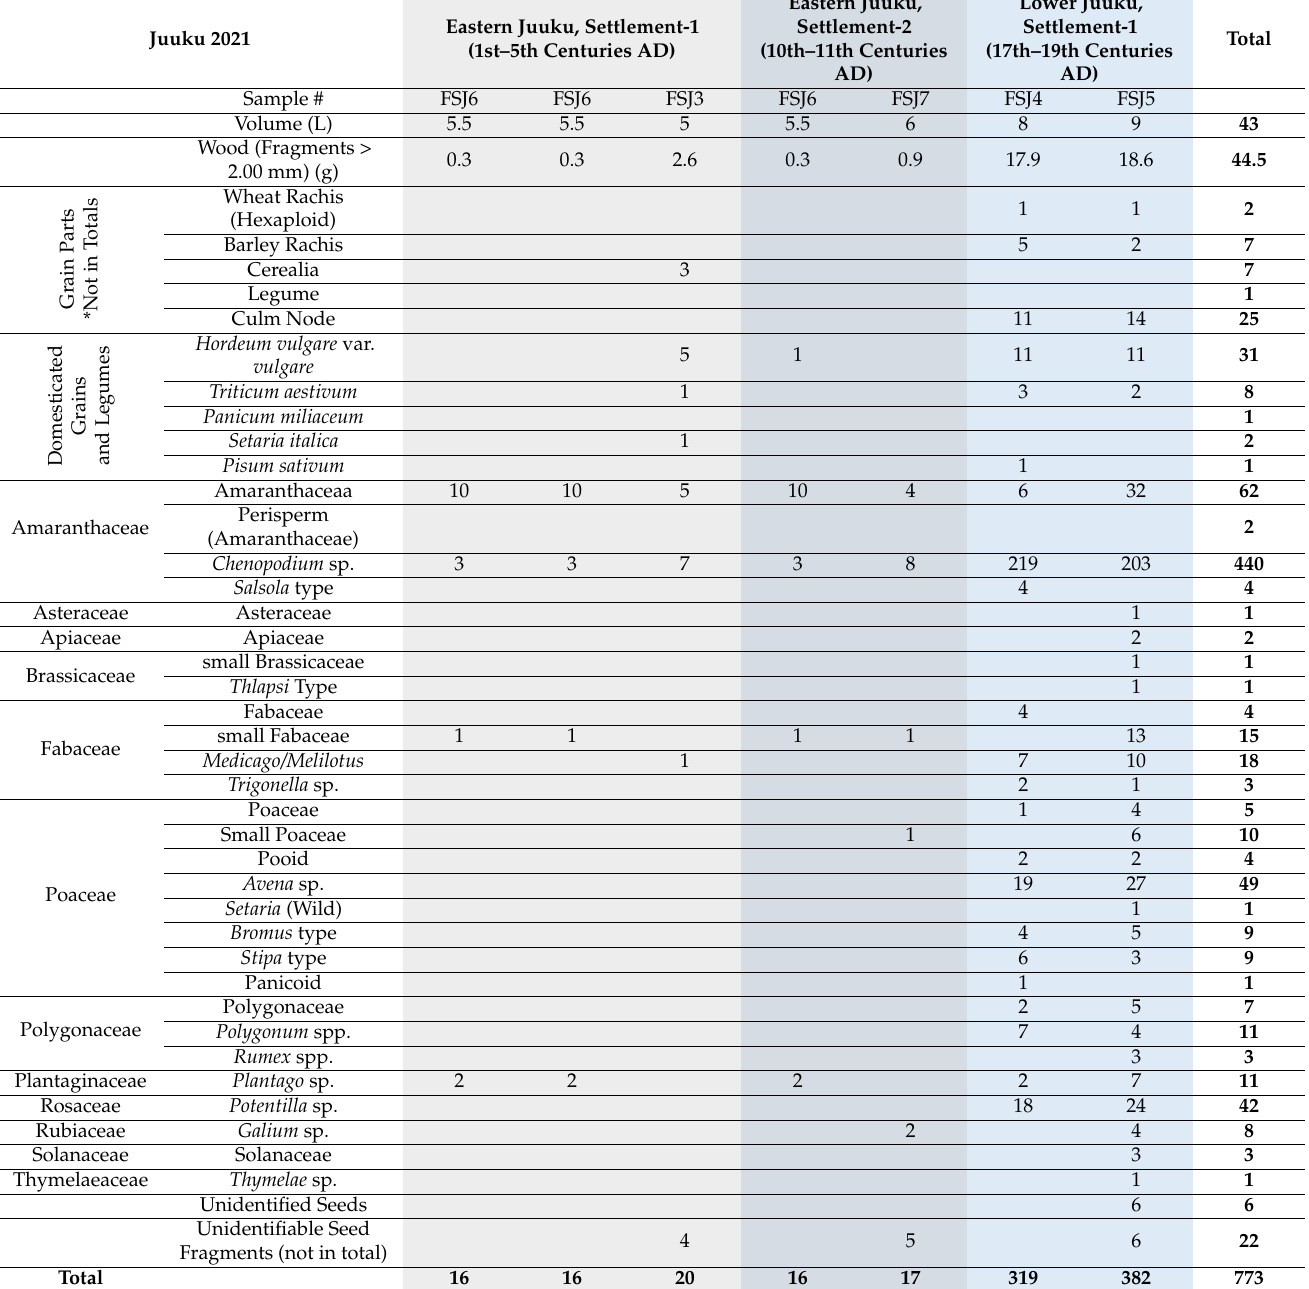
Table 5. Archaeobotanical counts from each Juuku Valley